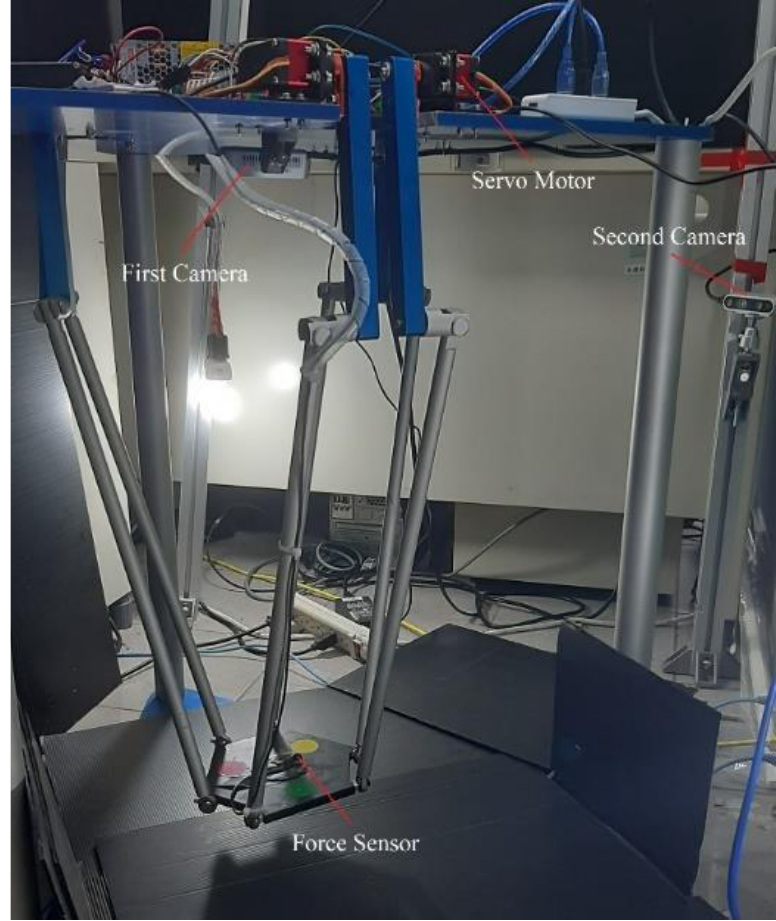
Figure 8. The Hexa robot system.